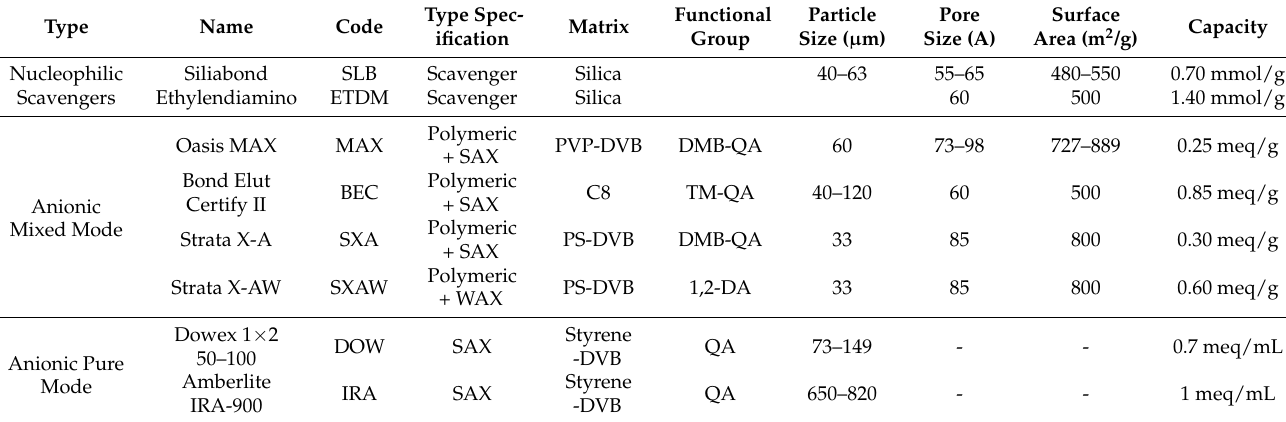
Table 3. Characteristics of the resins considered in the